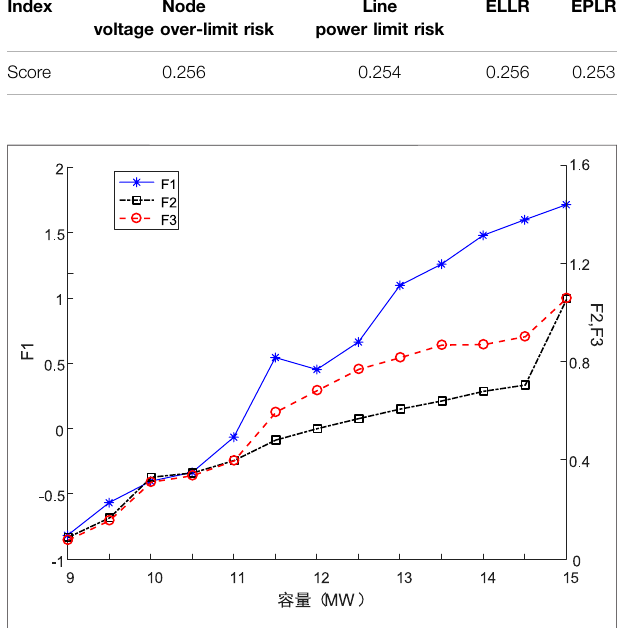
FIGURE 11 | Comprehensive risk assessment indicator results with different EV